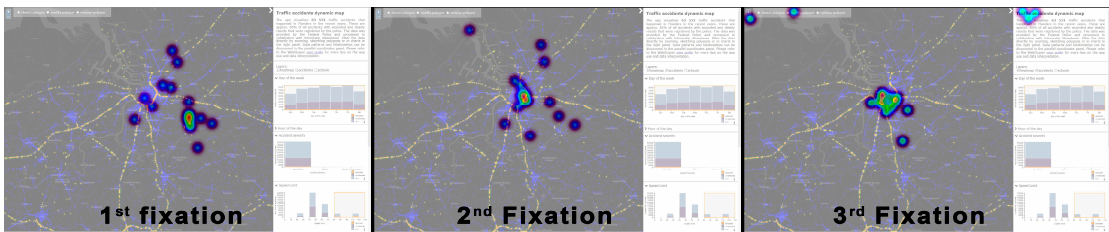
ISPRS Int. J. Geo-Inf. 2019 , 8 , x FOR PEER REVIEW Figure 8. Attention map for stimulus 5 of Flanders map showing first, second, and third fixation.